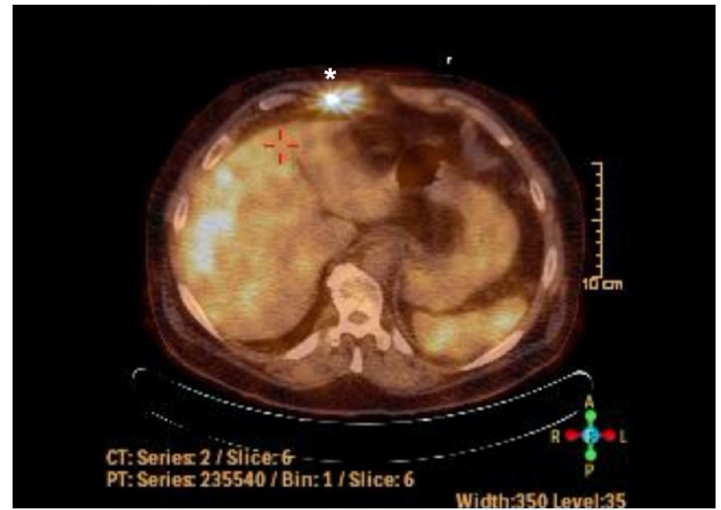
Figure 1. PET-CT scan of the upper abdomen before complex wound treatment. * PET positive driveline of the LVAD-System.